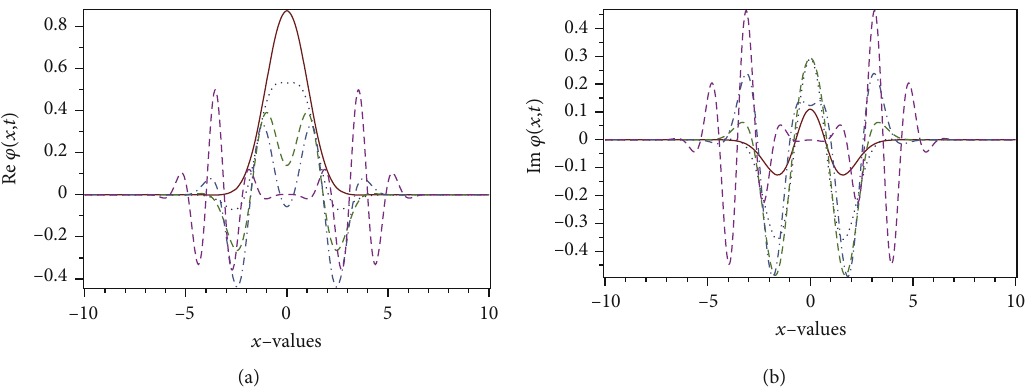
Figure 1: Real and imaginary parts of solution of (43) for a = b = 1, k = 1/2, t = 1, t = 2, t = 4, t = 5, t = 7, and g ð x Þ = 0 .